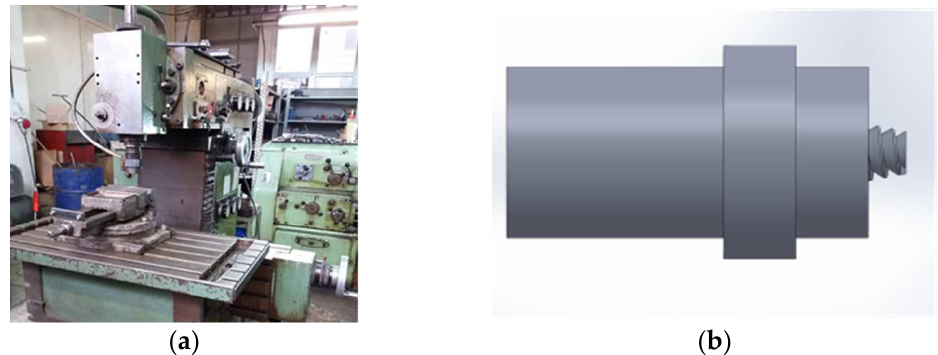
Figure 3. Equipment used for the FSW experiments, consisting of a mill machine with the following characteristics: Speed control ( a ); FSW tool manufactured for the present work—the length of the pin: 2.62 mm ( b ).